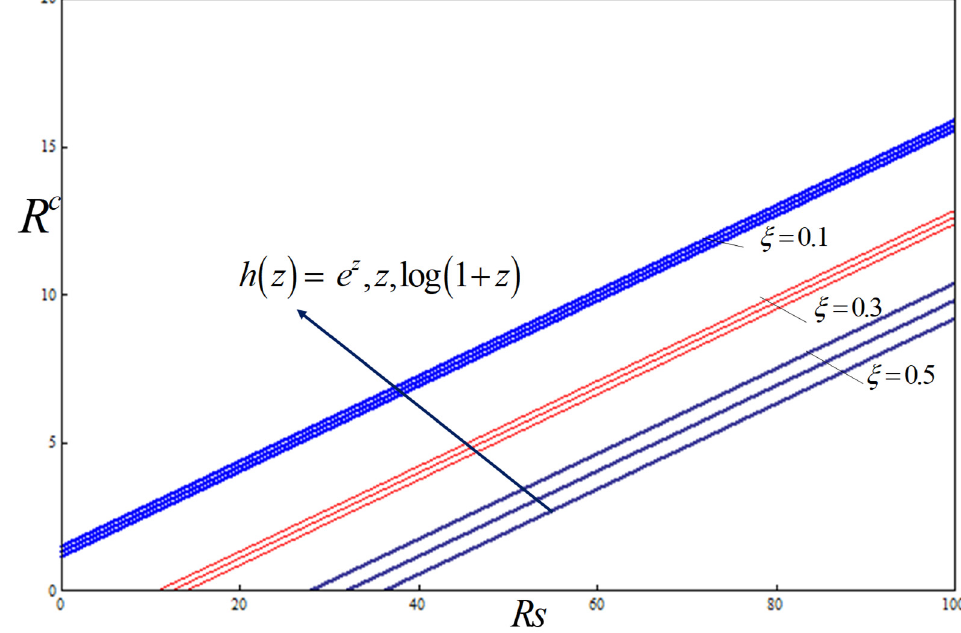
Figure 14. Plot of R c versus Rs for three cases of positive gravity fluctuation for various values of ξ with Le = 0.5, Rs = 10, Da = 0.1, η = 0.5 and δ =